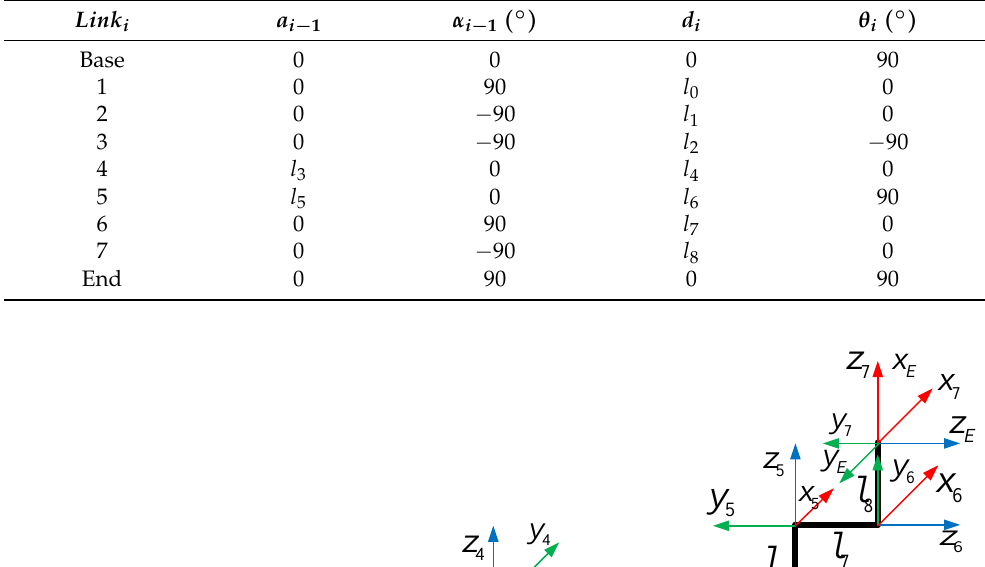
Table 1. D-H Parameters of the CMM/EMM.